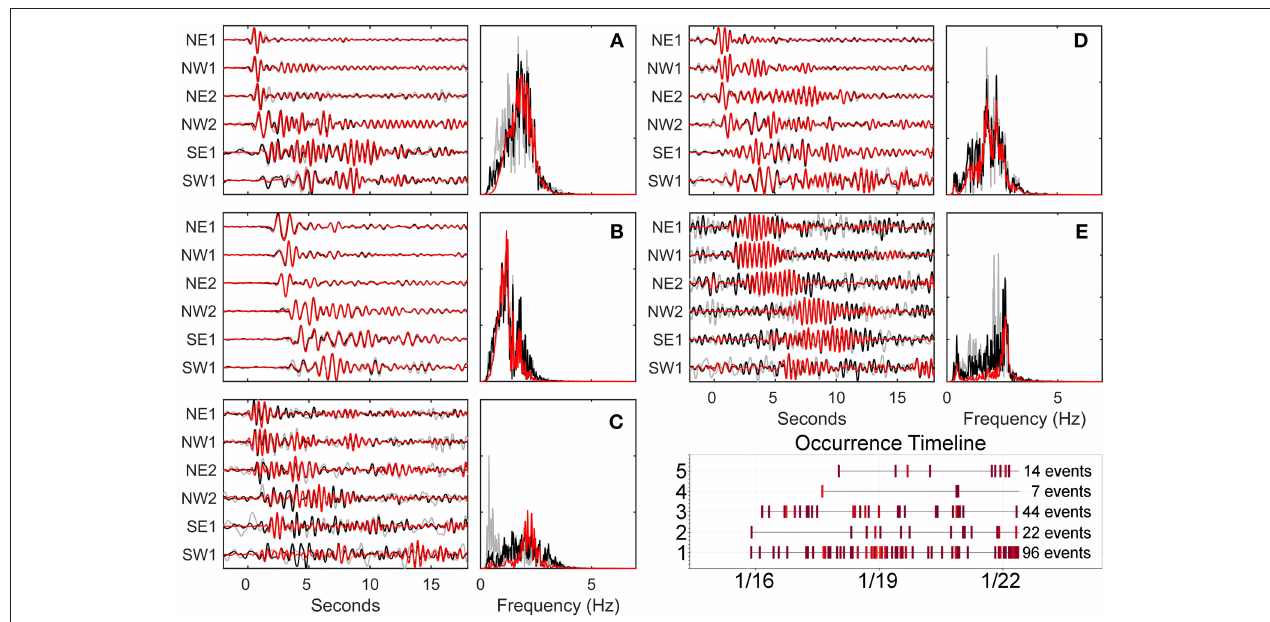
FIGURE 3 | Repeating earthquakes detected by REDPy. The gray lines in (A–E) represent the core event identified by the OPTICS algorithm for each cluster of events. The black line is a simple linear stack, and the red line is the phase weighted stack showing improved SNR. All the traces in the left section of each panel are of vertical components, and spectra are taken from the vertical component of NE1. Constituent waveforms are all filtered from 0.5 to 5Hz with a 4 pole bandpass filter prior to any stacking, and each panel shows normalized traces. (A) Cluster 1 (B) Cluster 2 (C) Cluster 3 (D) Cluster 4 (E) Cluster 5 (F) Times for each event with cluster numbers on y axis and number of total events recorded to right of timeline (in cases where events overlap due to scale constraints, lighter shades signify more